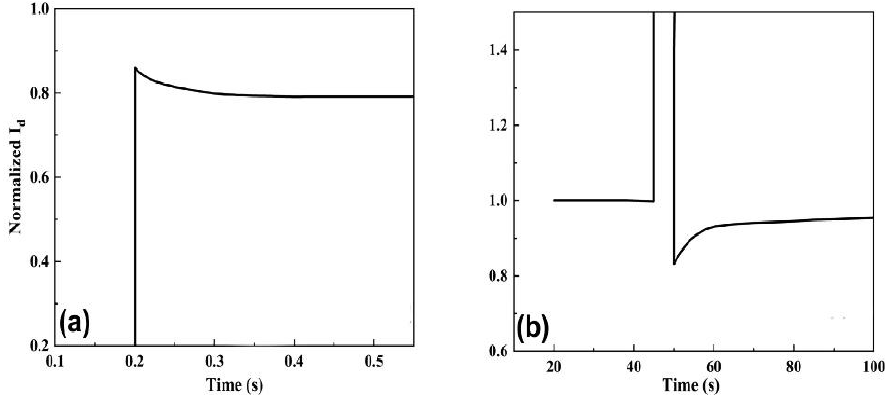
Figure 32. For AlGaN/GaN HEMTs, the transient waveform of the drain current from the drain lag phenomena. ( a ) turn-on pulsing mode ( b ) turn-off pulsing mode. Reproduced with permission [157]. Copyright 2009, the author (s), published by AIP Publishing.